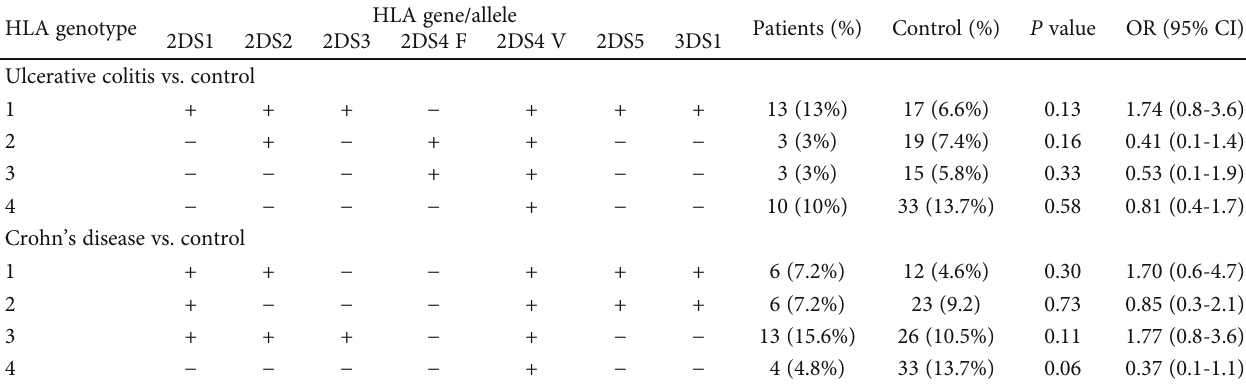
Table 4: Activating KIR (aKIR) genotypes in normal individuals and IBD